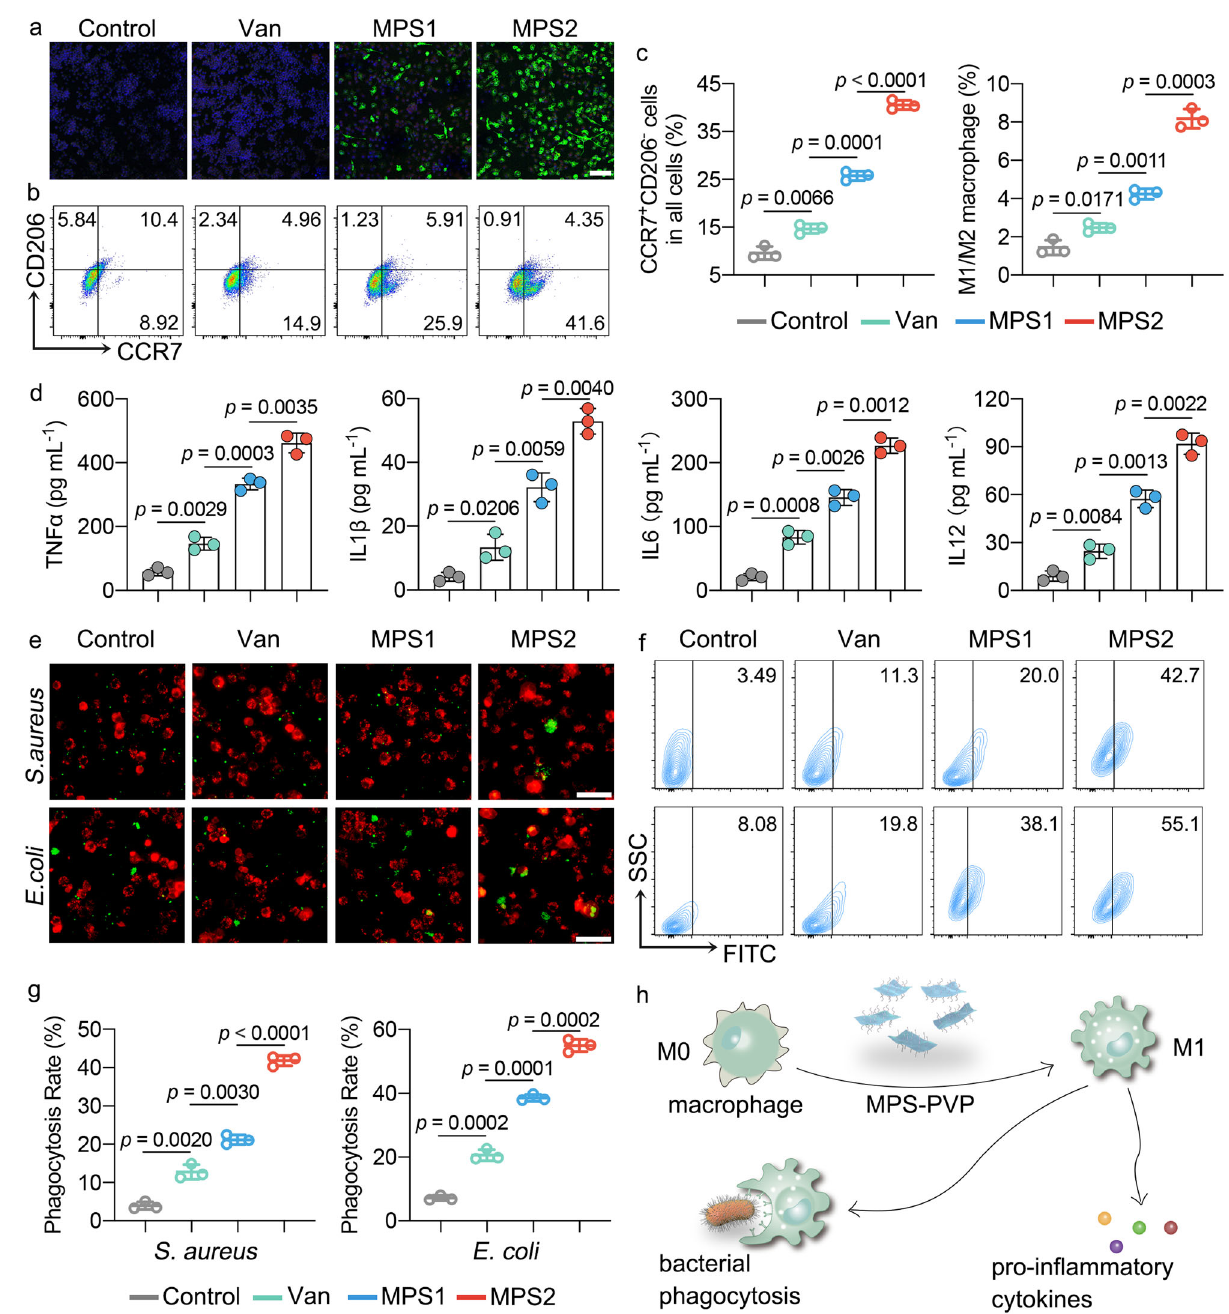
Fig. 5 | Immune-stimulatory MPS-PVP facilitates antigen processing and pre- sentation of RAW264.7 macrophages. a Immuno fl uorescence staining of RAW264.7macrophagesforiNOS(green),CD206(red),and DAPI(blue). Scalebar, 100 μ m. b , c Flow cytometry analysis displaying changes in CCR7 (M1 marker) and CD206 (M2 marker) expression in RAW264.7 macrophages after different treat- ments. M1/M2 macrophage equals to CCR7 positive/CD206 positive cells. d Concentrations of TNF α , IL1 β , IL6, and IL12 in the supernatants of RAW264.7 macrophages after indicated treatments. e Fluorescence staining showing the bacterial phagocytosis 60min after RAW264.7 macrophages (red) and bacteria